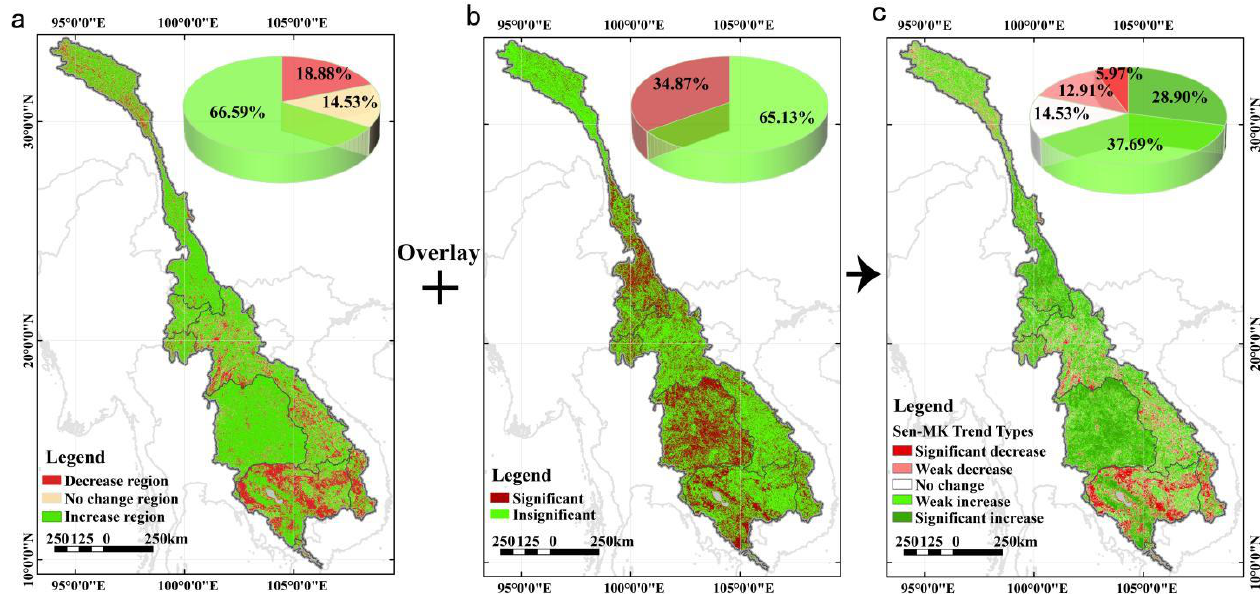
Figure 5. Spatial distribution of Sen-MK trend types. ( a ) Sen slope estimation results; ( b ) Mann– Kendall significance test; ( c ) Sen-MK trend coupling type.